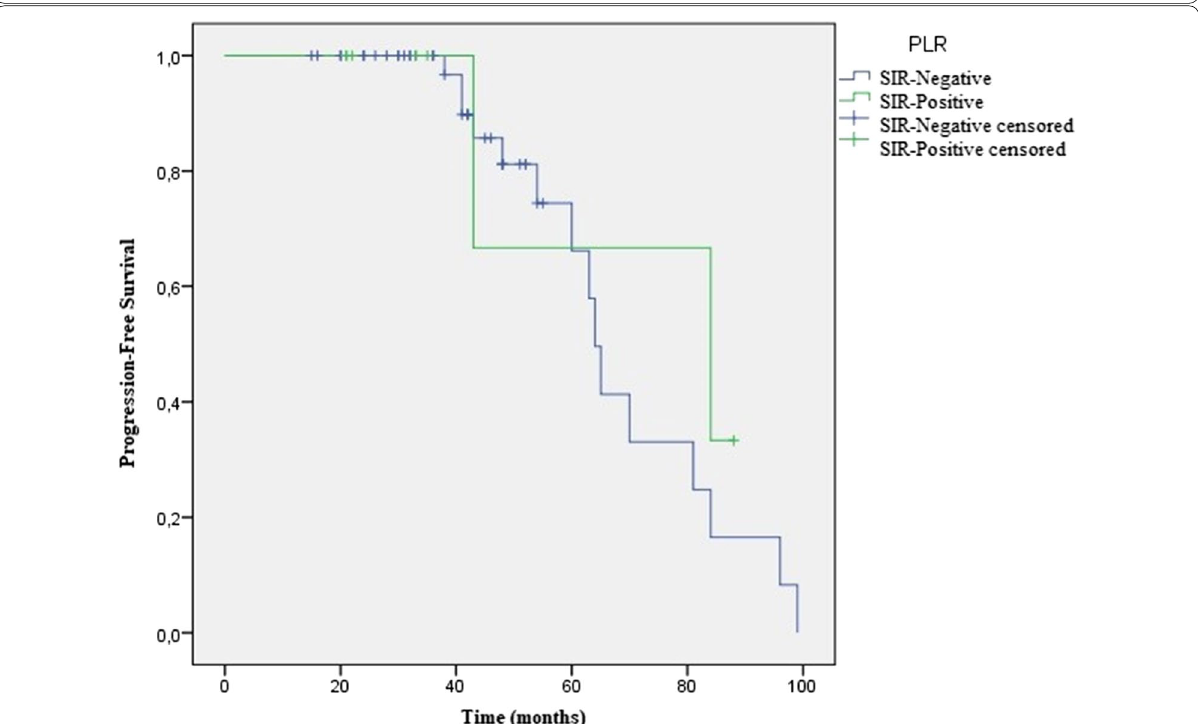
Fig. 3 Platelet/lymphocyte ratio (PLT)–progression-free survival: SIR (systemic inflammatory response)—negative, SIR (systemic inflammatory